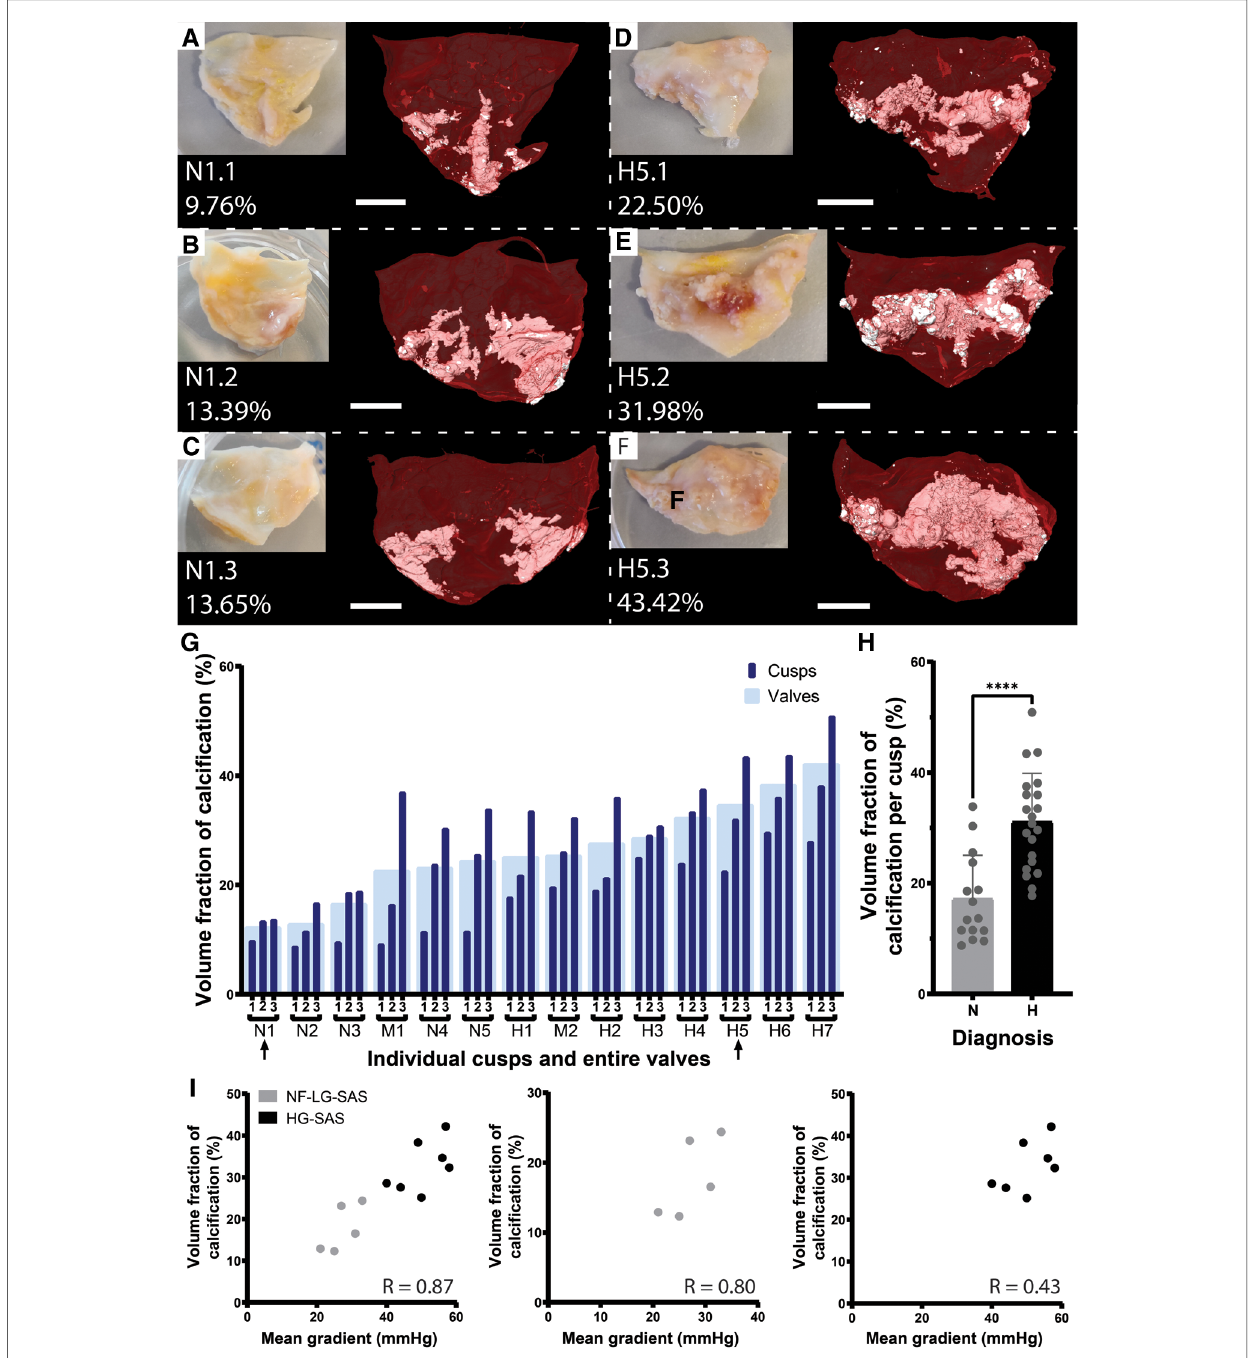
FIGURE 1 Quanti fi cation of the volume fraction of calci fi cation per cusp and per valve. ( A – F ) Photographs and microCT-based 3D renderings of the three cusps for patient N1, diagnosed with NF-LG-SAS ( A – C ) and patient H5, diagnosed with HG-SAS ( D – F ). For the 3D renderings, soft tissue is shown in red and calci fi cation in white. Scale bars=5 mm. ( G ) Volume fraction of calci fi cation for each cusp (dark blue) and for the entire valve (light blue). Arrows indicate the samples illustrated in ( A – F ). ( H ) Bar graph comparing the mean volume fraction of calci fi cation for the NF-LG-SAS and HG-SAS groups. Individual datapoints are given for each cusp ( n =15 and n =21 per group respectively). ( I ) Correlation between the volume fraction of calci fi cation and the mean pressure gradient across the aortic valve for all patients (left), NF-LG-SAS patients (center) and HG-SAS patients (right). N, NF-LG-SAS; M, moderate AS; H, HG-SAS, ****: p